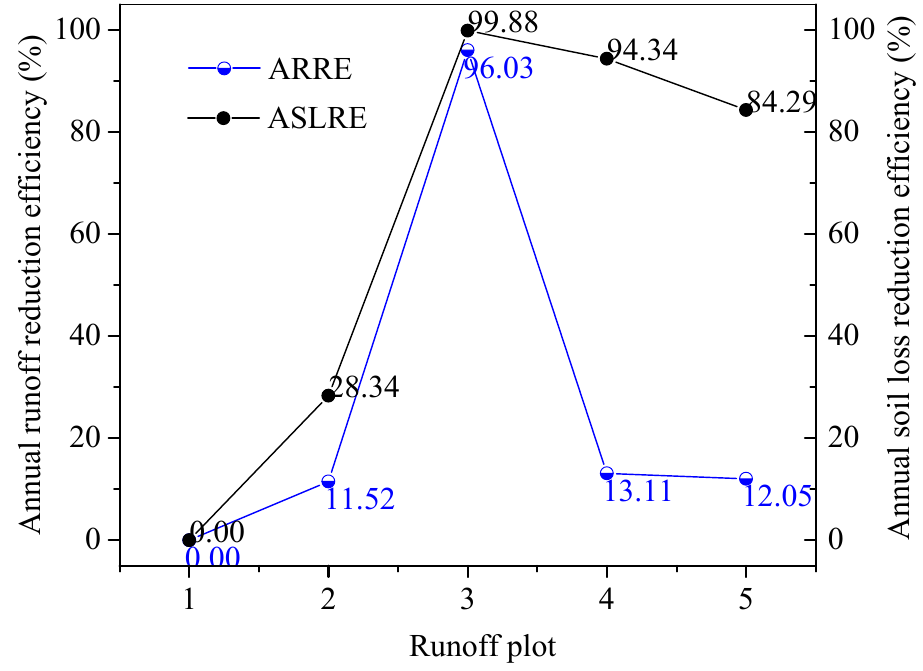
Figure 4. Annual runoff reduction efficiency and annual soil loss reduction efficiency of the soil conservation measures on the selected plots. Runoff and soil loss relationships for each plot under different rainfall regimes are shown in Figure 6. The scattered points were fitted with linear regressions. The slope b of the linear regression function y = a + bx reflects the sensitivity of the soil to erosion. Similarly, impacted by soil conservation measures and the slope gradient, the changing pattern of the b values agreed with those of the mean annual AH and SLR. For all the erosive rainfall events, the b value on plot 1 was the highest at 35.39, followed by values of 30.82 on plot 2, 9.04 on plot 5, and 1.94 on plot 4. However, there was no apparent relationship between runoff and soil loss on plot 3. For individual runoff plots, the b values were usually less under rainfall regime A, and higher under rainfall regimes B and C. For example, for plot 1, the b value was 25.16 under rainfall regime A, however the b values were 38.14 and 28.04 under regimes B and C,